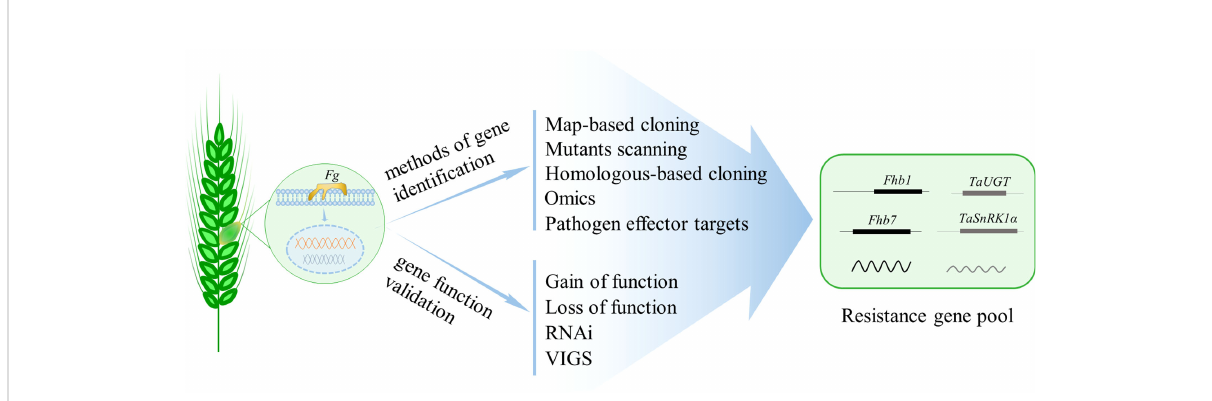
FIGURE 1 Methods to identify and validate genes that show resistance to Fusarium graminearum ( Fg ) and compose the resistance gene pool for wheat FHB resistance breeding. Map-based cloning and mutants scanning are two widely used approaches in gene identifying, while the latter is rarely applied in the analysis of wheat FHB resistance partially due to the functional redundancy among homeologs in polyploid wheat. With the completion of wheat genome sequencing, the popularized reverse-genetic approaches such as homologous-based cloning and omics technology are capable of identifying FHB resistance genes. Additionally, identifying the targets of pathogen effectors is also effective in wheat resistance gene identi fi cation. Finally, various gene gain- or loss-of-function technologies, or gene knockdown approaches such as RNAi and VIGS, are applicable to validate gene function in wheat FHB